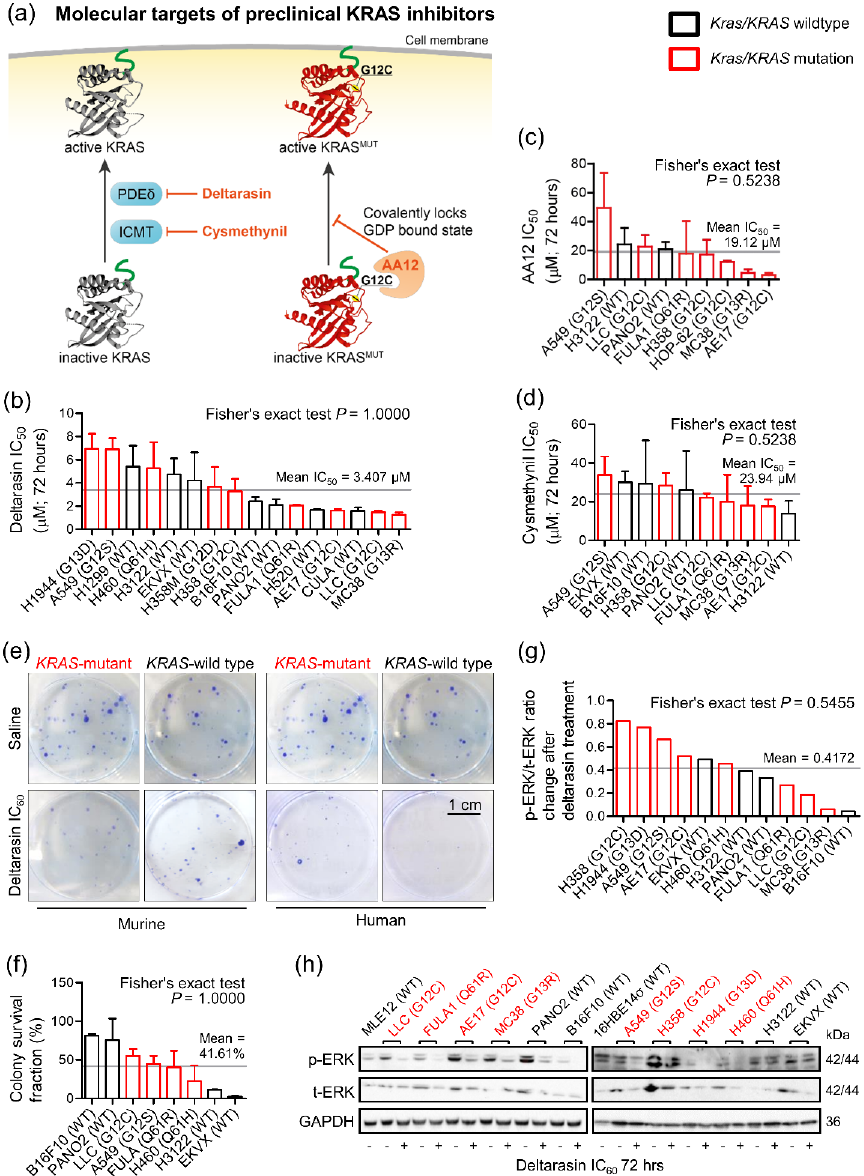
Figure 1. Pharmacologic evidence for KRAS mutation-independence in vitro. Different mouse and human tumor cell lines with (red) and without (black) Kras/KRAS mutations (codon changes are given in parentheses) were assessed for cell viability via colorimetric WST-8-assay, for colony formation via crystal violet-stained colony counts, and for ERK phosphorylation via phospho (p)- and total (t)-ERK immunoblots after 72-h treatments with three different KRAS inhibitors ( n = 3/data-point). ( a ) Graphical scheme displaying molecular targets of preclinical KRAS inhibitors AA12, cysmethynil, and deltarasin. 3D protein structures obtained from RCSB PDB: human KRAS WT (5VQ8, black), human KRAS G12C (4LDJ, red). ( b – d ) IC 50 of deltarasin ( b ), AA12 ( c ), and cysmethynil ( d ) as assessed via WST-8 assay. ( e , f ) Representative images of colonies after saline or IC 60 deltarasin treatment ( e ) and colony survival fraction ( f ) after IC 60 deltarasin, normalized to saline treatment. ( g , h ) Quantification of normalized p-ERK/t-ERK signal change after IC 60 deltarasin, normalized to GAPDH ( g ) and representative immunoblots ( h ). ( b – d , f , g ) Data presented as mean ± SD. Grey lines represent the mean of all cell lines tested, which was used to dichotomize cell lines into sensitive and resistant. p , probability according to Fisher’s exact test for cross-tabulation of Kras/KRAS mutation status to drug sensitivity/resistance. KRAS, KRAS proto-oncogene GTPase; WT, wild-type; GAPDH, glyceraldehyde 3-phosphate dehydrogenase; ERK, extracellular-signal regulated kinase.